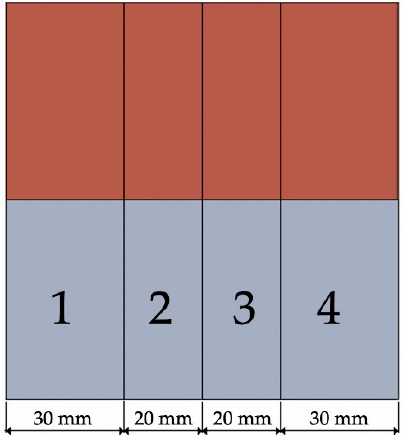
Figure 3. Schematic representation of weld samples.